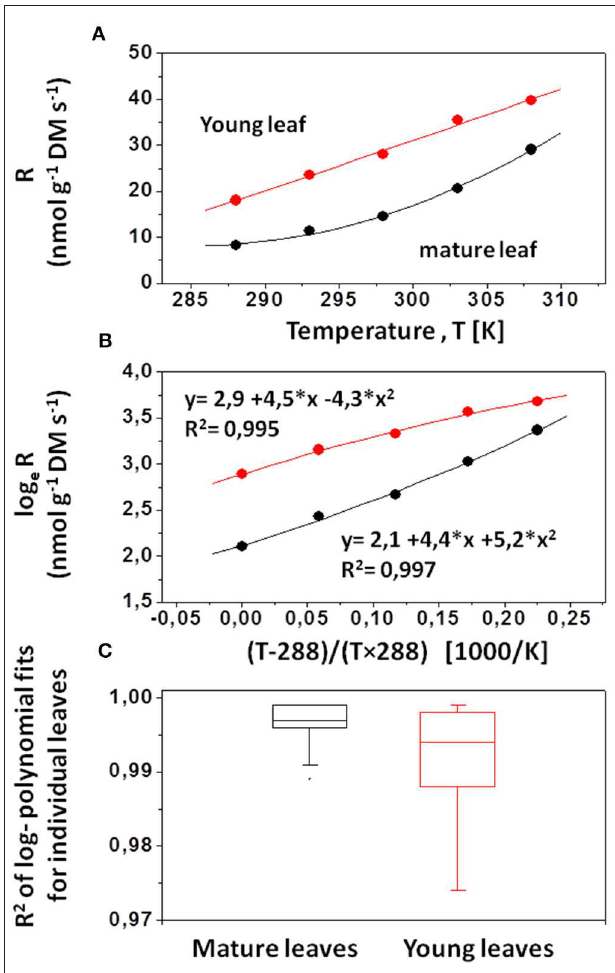
FIGURE 1 | Determination of respiration parameters obtained via calorimetry. (A) Rates of mitochondrial oxygen reduction (nmol g − 1 DM s − 1 ) were determined indirectly from heat rates of living tissue ( µ W g − 1 DM s − 1 ) at five measurement temperatures (Equation 2). (B) Respiration rates were log e –transformed and plotted against reciprocal temperature (i.e., the temperature term in Equation 4 in units of 1,000/K). The intercept of individula log- polynomial fits (at T term = 0) is equivalent to lnR ref (i.e., log e –transformed rates of respiration at 288K reference temperature). The second parameter descibes the slope of the log- polynomial response curve infinitesimally close to T ref , and is a measure of the activation energy of R at T ref (i.e., µ Ref = E o / R ; µ Ref in units of kK). The third parameter descibes the curvature of the log- polynomial response, i.e., the change in activation energy as measurement temperature increases ( δ R in units of kK 2 ). For δ R > 0 the curvature is concave upwards (as for the exemplary mature leaf), and for δ R < 0 it is convex downwards (as for the exemplary young leaf). (C) Coefficients of determination ( R 2 ) for log- polynomial fits on mature leaves ( N = 72) and young leaves ( N = 72). Each box indicates 25 and 75% percentiles of observed R 2 – values. The median is indicated by the horizontal line within respective